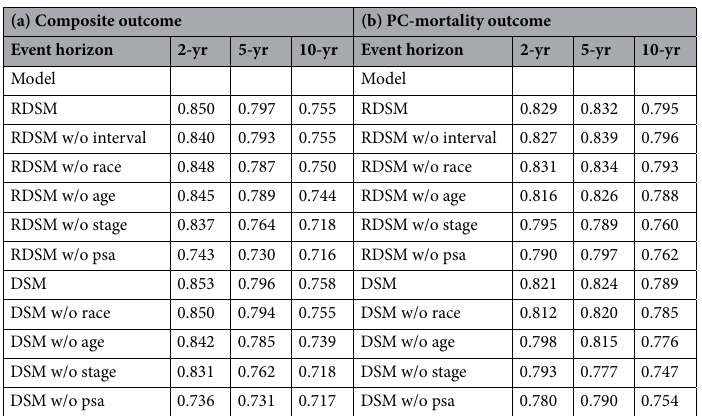
Table 3. Ablation study results for the composite (left) and PC-mortality (right) outcomes. For reference, the results also include all input variables on the top row of the table.